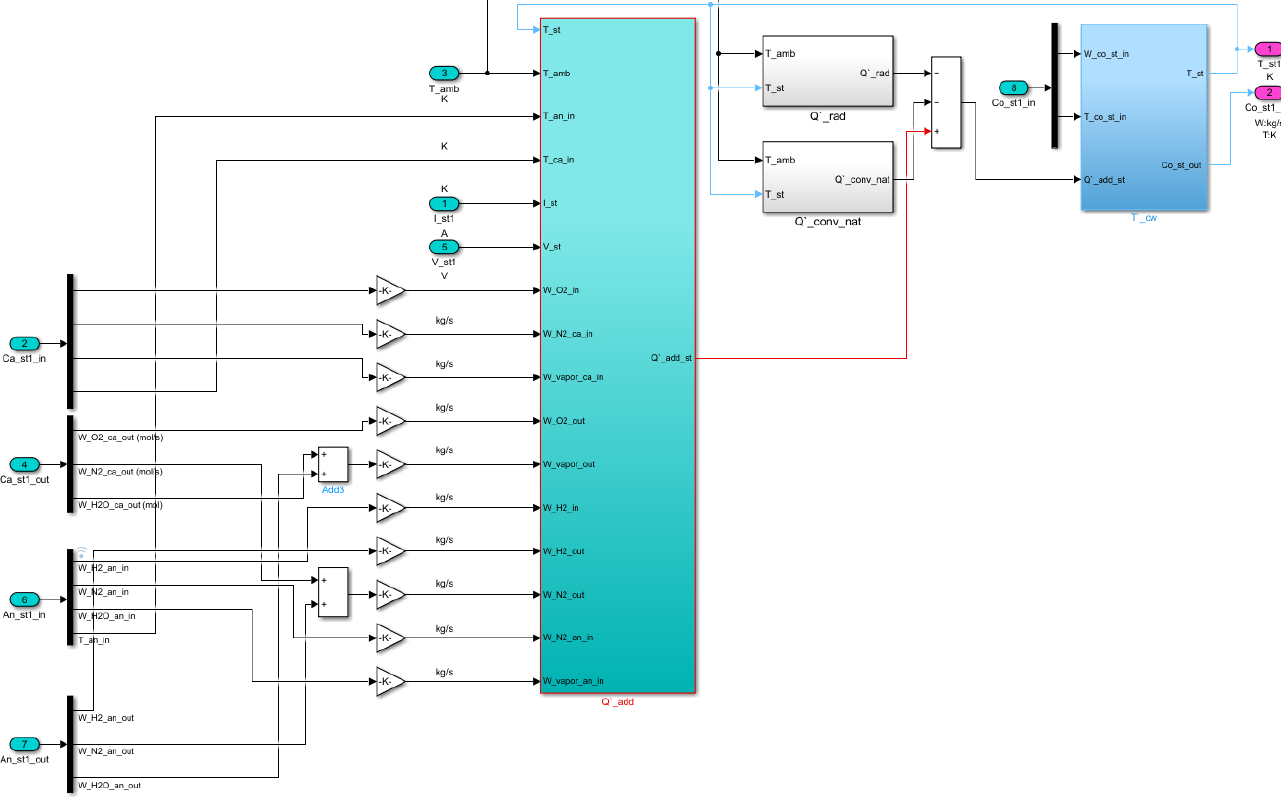
Figure 14. The Simulink model of the stack temperature.